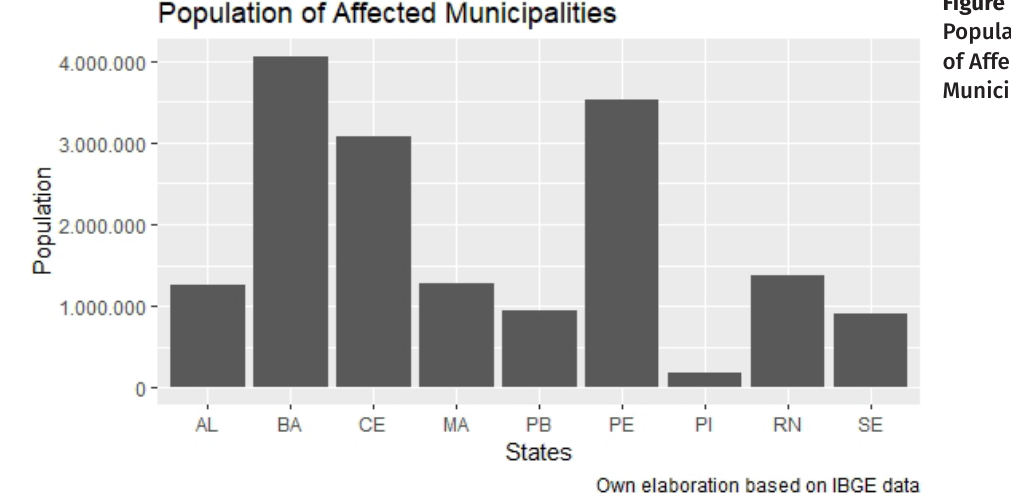
Population of Affected